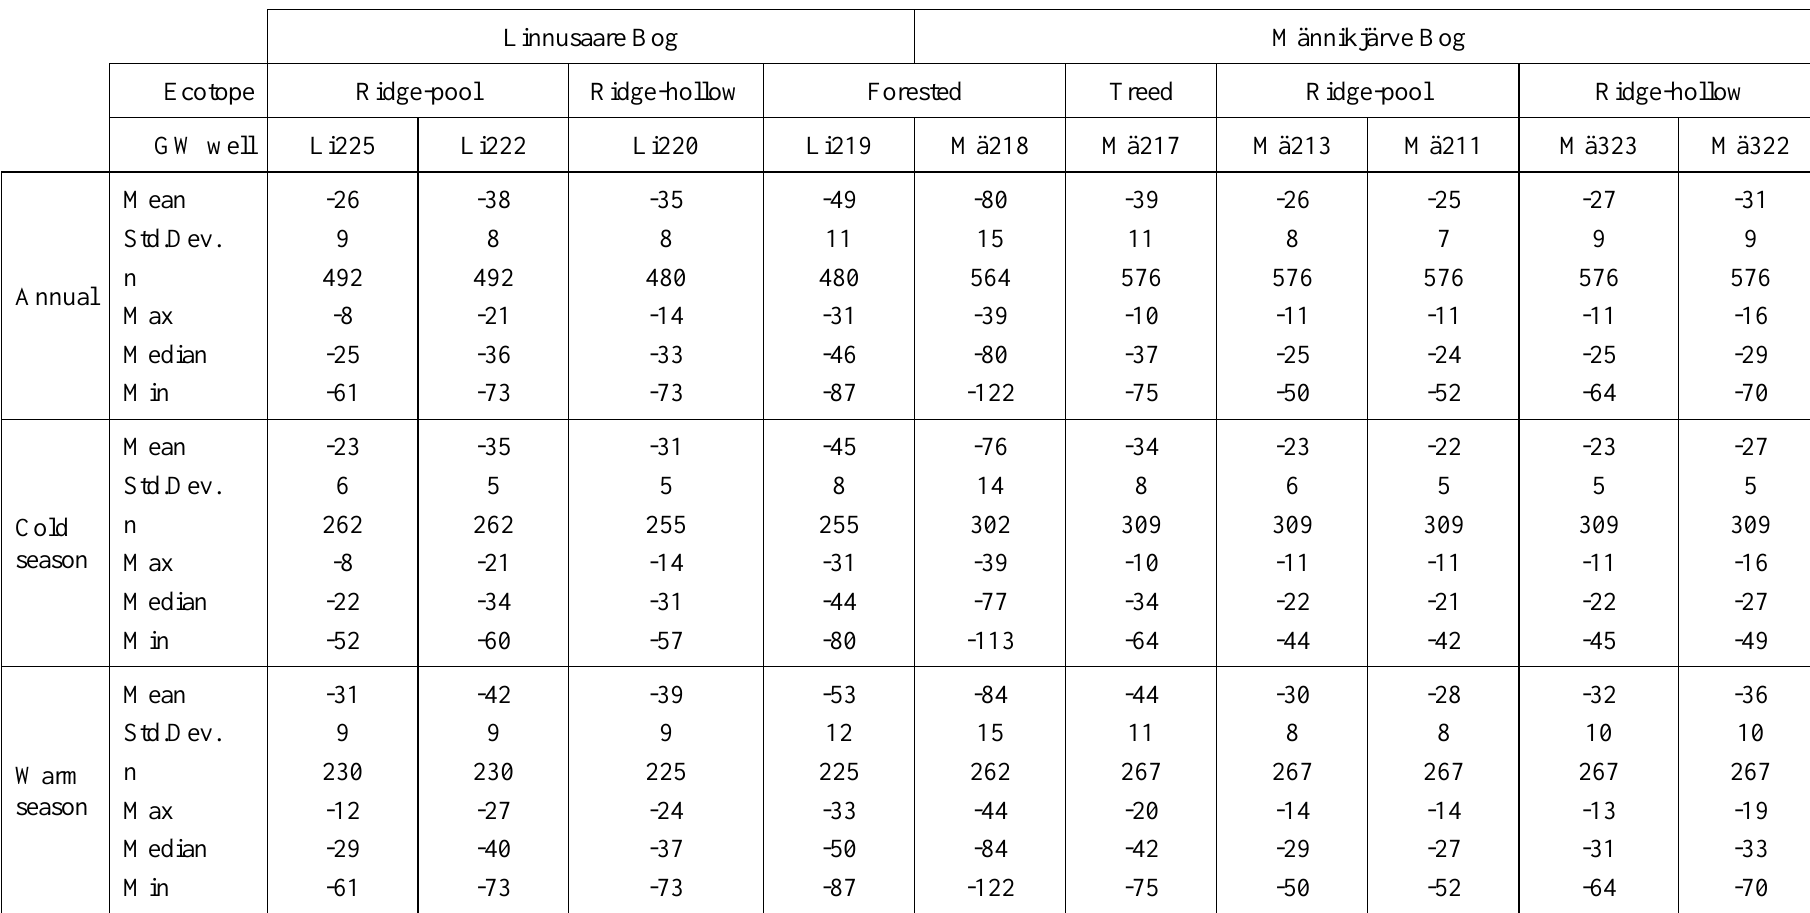
Table A1. Statistics for 50-year monthly GWLs (cm) in different ecotopes of Linnusaare (Li) and Männikjärve (Mä) Bogs. In this Table and elsewhere, GWLs below the soil surface are indicated by